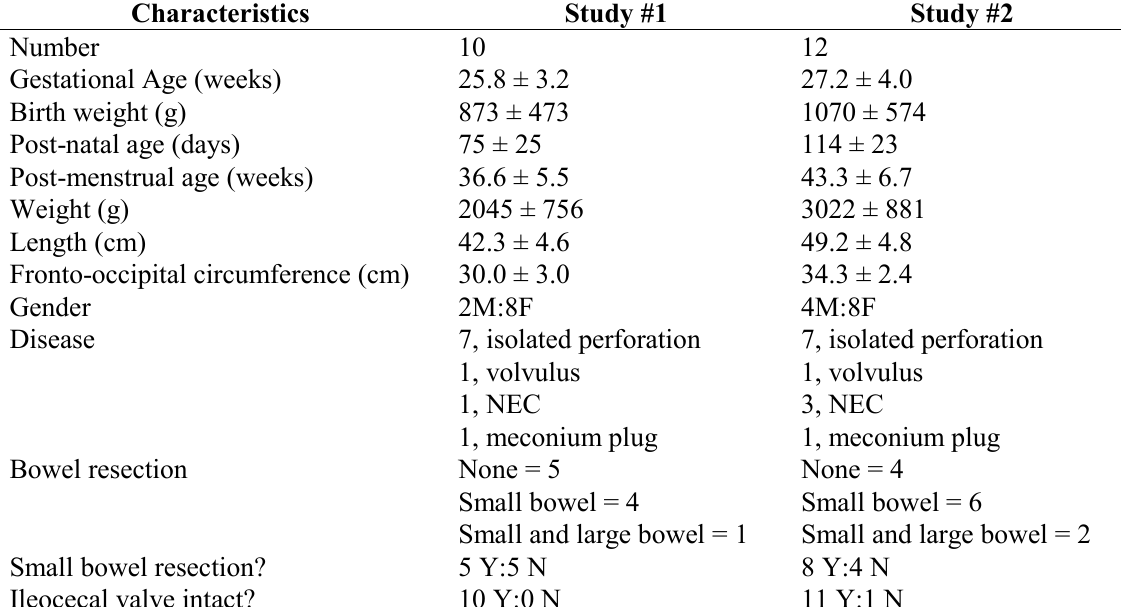
Table 1. Demographic data of the